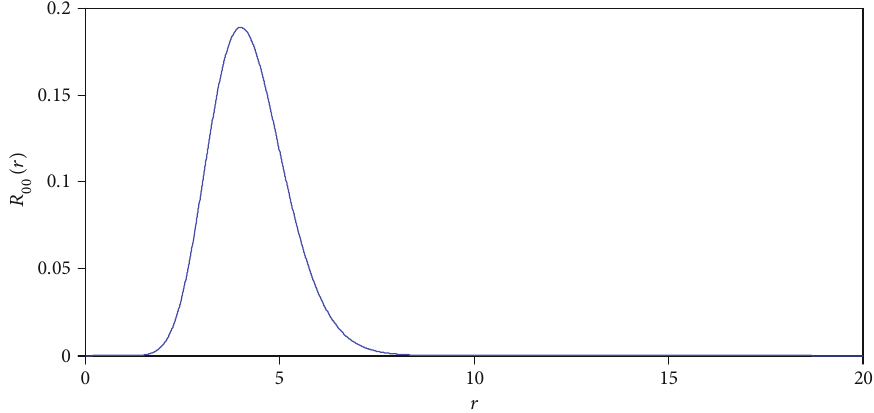
= V = 1 and α = 0 : 05,0 : 1 . 0 1